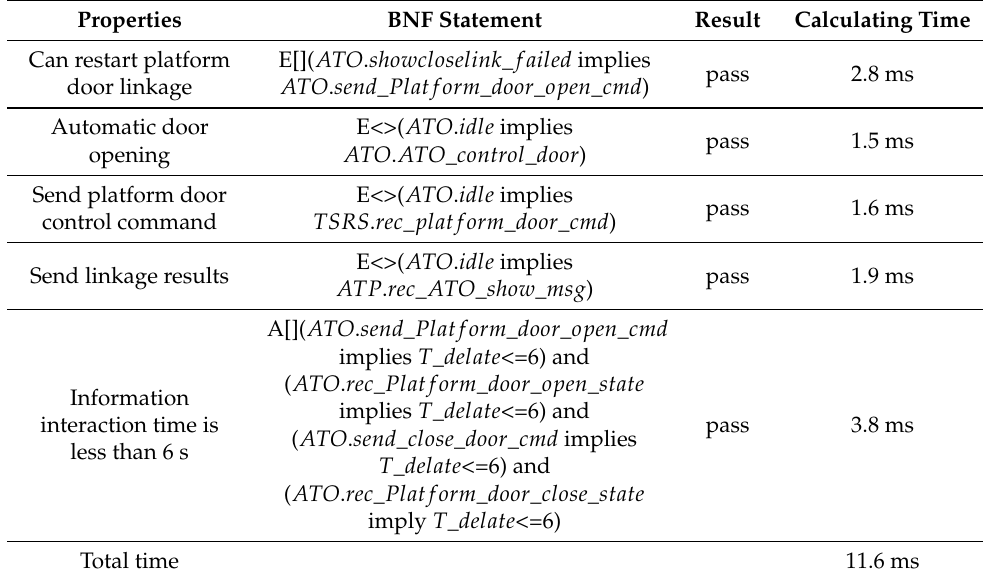
Table 4. TA model validation results.